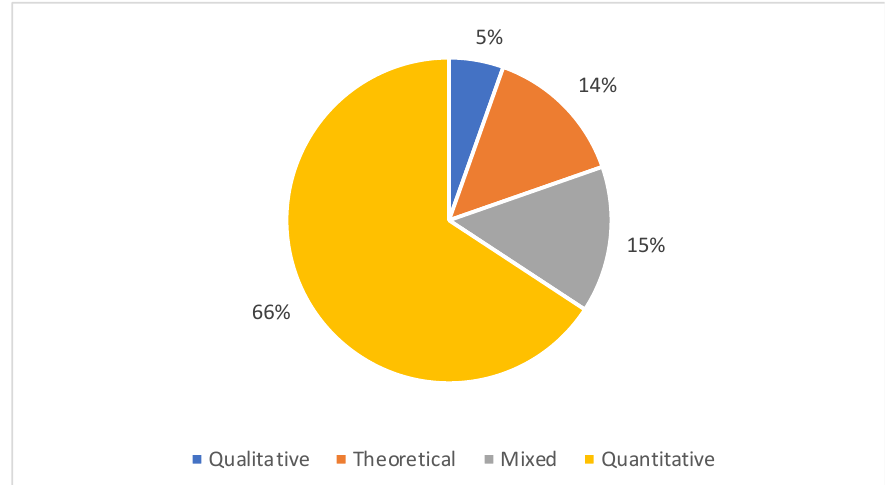
Figure 4. Paper’s methodology . Source: Authors’ own elaboration .